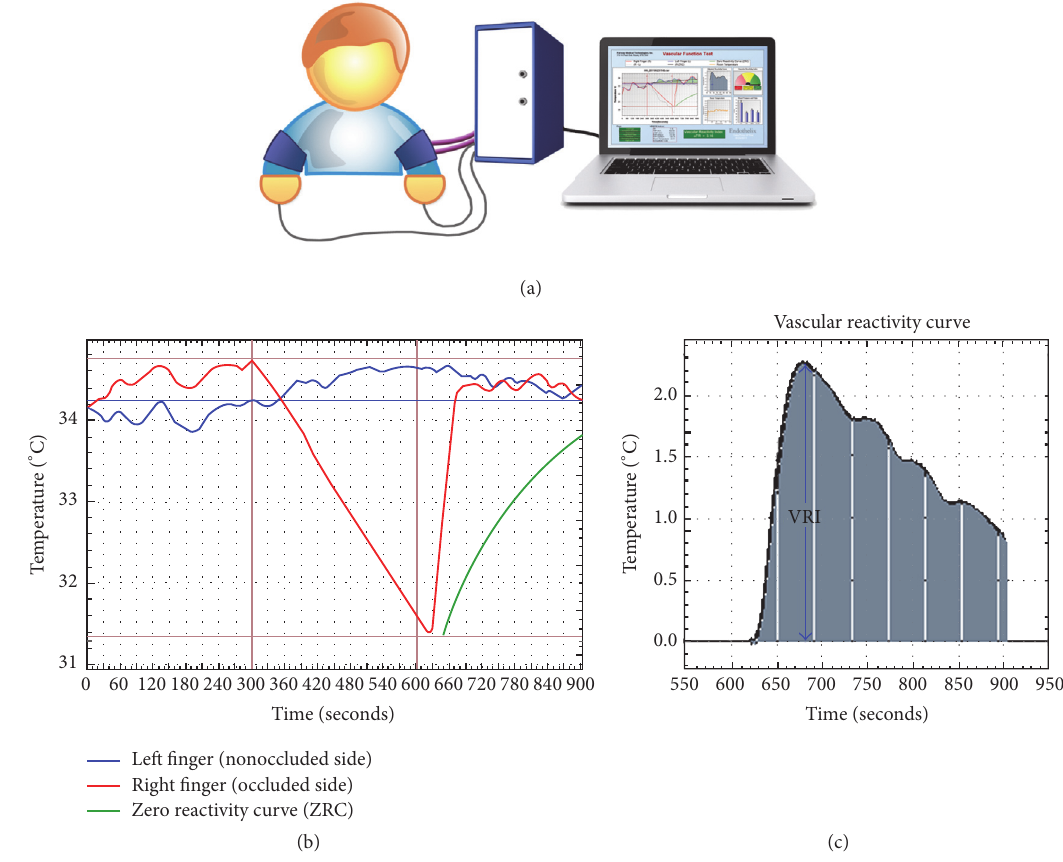
Figure 1: (a) Illustration of patient setup, with temperature sensors affixed to both index fingers and blood pressure cuffs on both arms. (b) A sample report screen displays a right finger temperature curve (red), a left finger temperature curve (blue), and a zero reactivity curve (green). (c) The software-generated, vascular reactivity curve is shown. The vascular reactivity index (VRI) is taken as the maximum value of this temperature curve during the reactive hyperemic